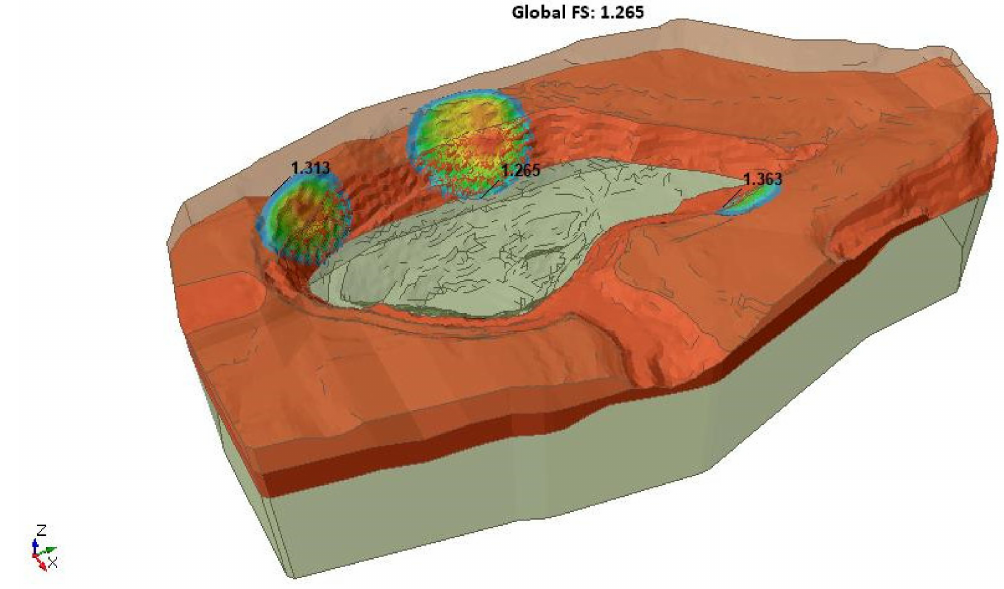
Figure 15. The contours of multi-material slip surfaces due to the effect of